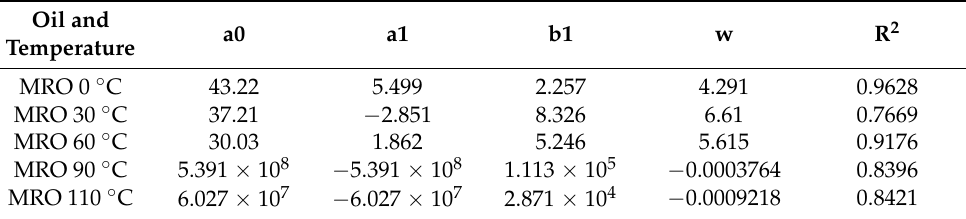
Table 5. Factors associated with Fourier distribution for MRO with 95%